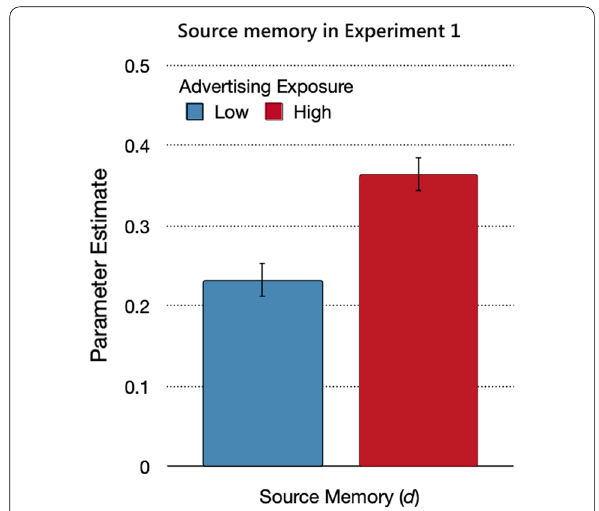
Fig. 3 Source memory in Experiment 1. Note : Parameter estimates of the source memory parameter d , reflecting the probability of correctly remembering the source of the statements from the advertising and trustworthy sources, as a function of advertising exposure (low, high). The error bars reflect standard